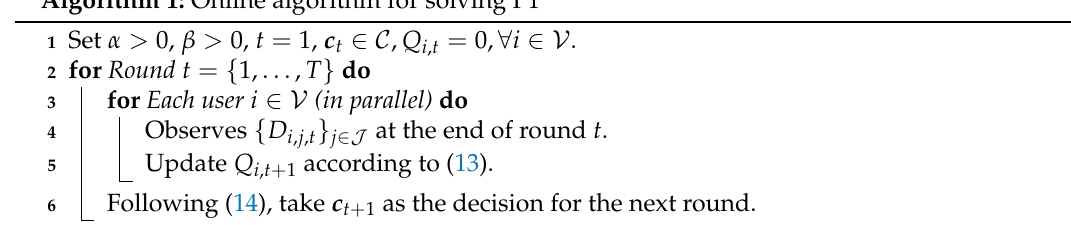
Algorithm 1: Online algorithm for solving